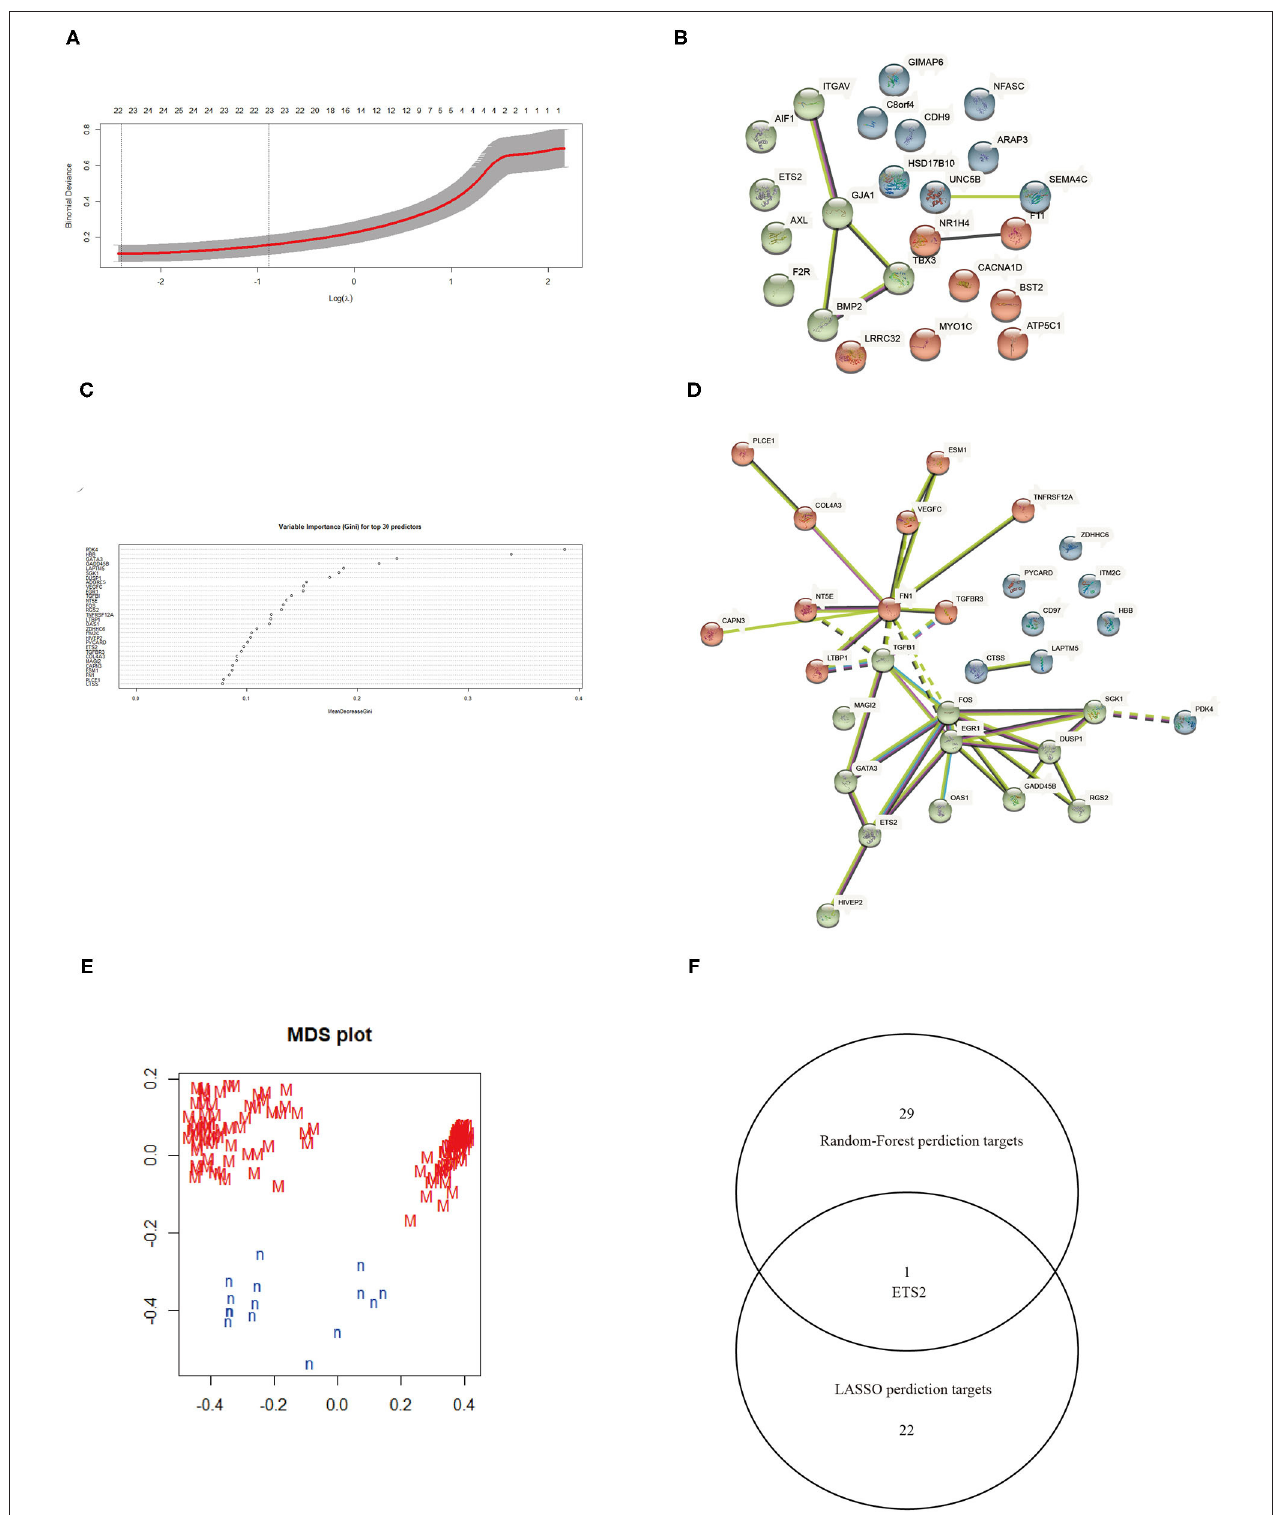
FIGURE 3 | (A) Selection of λ in the LASSO algorithm. (B) PPI network between LASSO algorithm results. (C) Top 30 results from the random forest algorithm. (D) PPI network between random forest algorithm results. (E) Random Forest algorithm learning status. (F) Venn map combining results from the LASSO and random forest